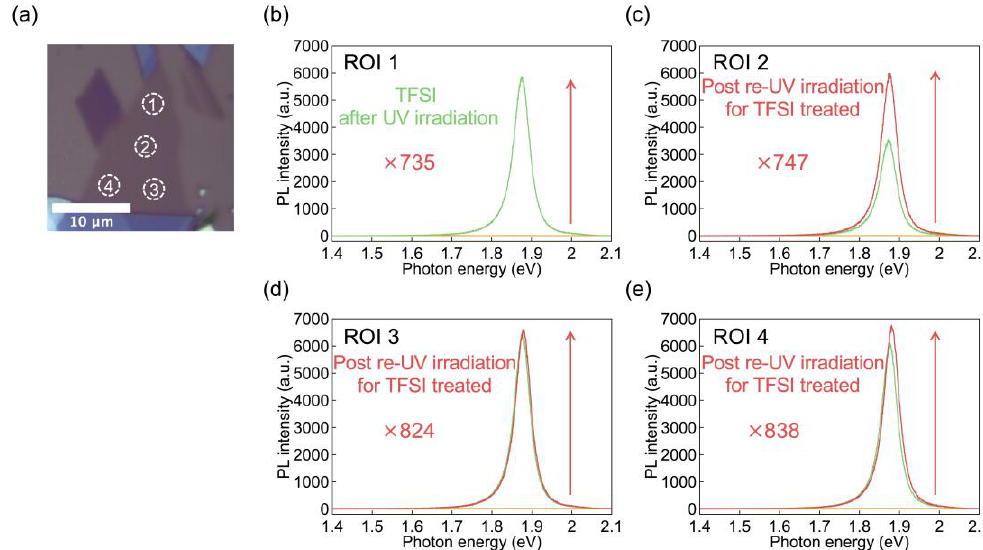
Figure 4. ( a ) Optical microscope image of the bilayer MoS 2 after the TFSI treatment followed by the UV irradiation. ( b – e ) PL spectra for the TFSI treatment (green) and the second (re-)UV irradiation (red) in ( b ) ROI 1, ( c ) ROI 2, ( d ) ROI 3, and ( e ) ROI 4 in Figure 4a. The values in Figure 4b–e are the magnitude of the PL enhancement in the sample over the as-exfoliated (original) sample.